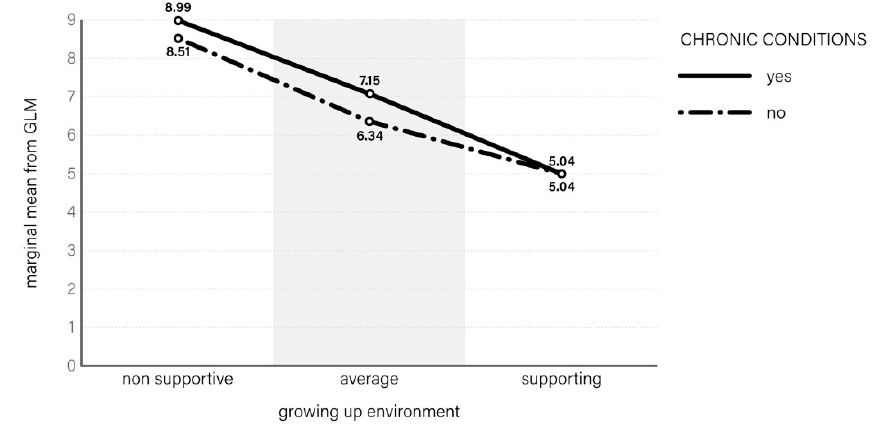
Figure 3. Stress level among students according to chronic-conditions status and growing-up environment.